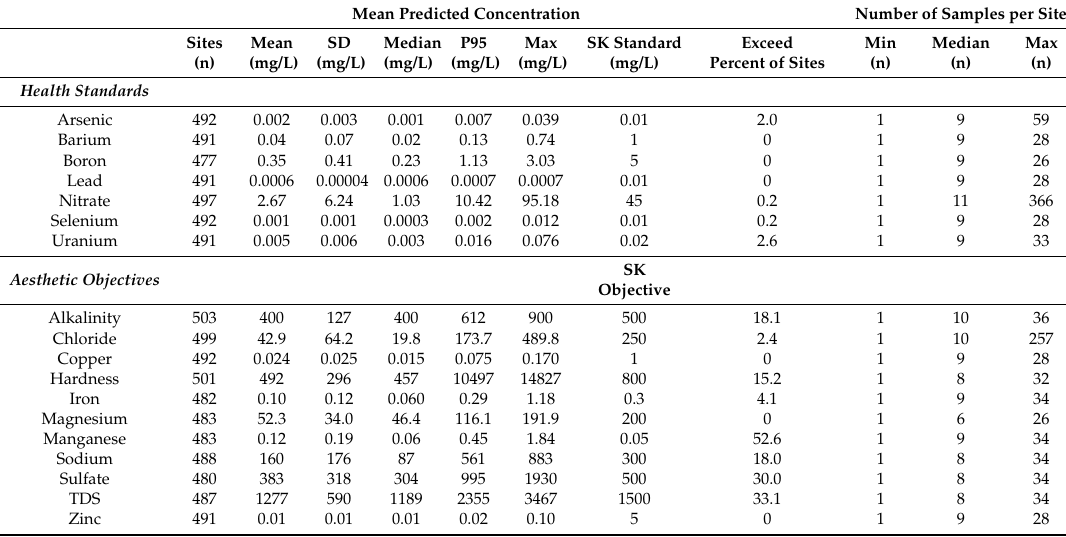
Table 3. Descriptive statistics for predicted concentrations after repeated measures modeling for each parameter by site for public water supplies in Saskatchewan, along with Saskatchewan standards and objectives, and the percent of sites with a predicted concentration exceeding the standard or objective. A summary of the number of samples per site incorporated in repeated measures models for each parameter is also